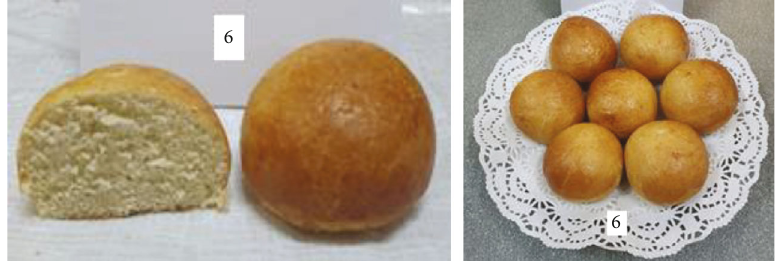
Figure 7: Sample no. 6 made from 15% chickpea fl our and 40g of sugar beet powder.